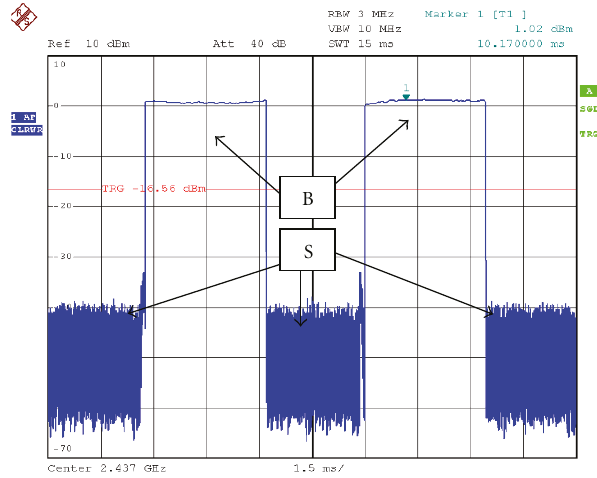
Figure 11: Received power waveform in time-domain when two sources beamform at the destination.